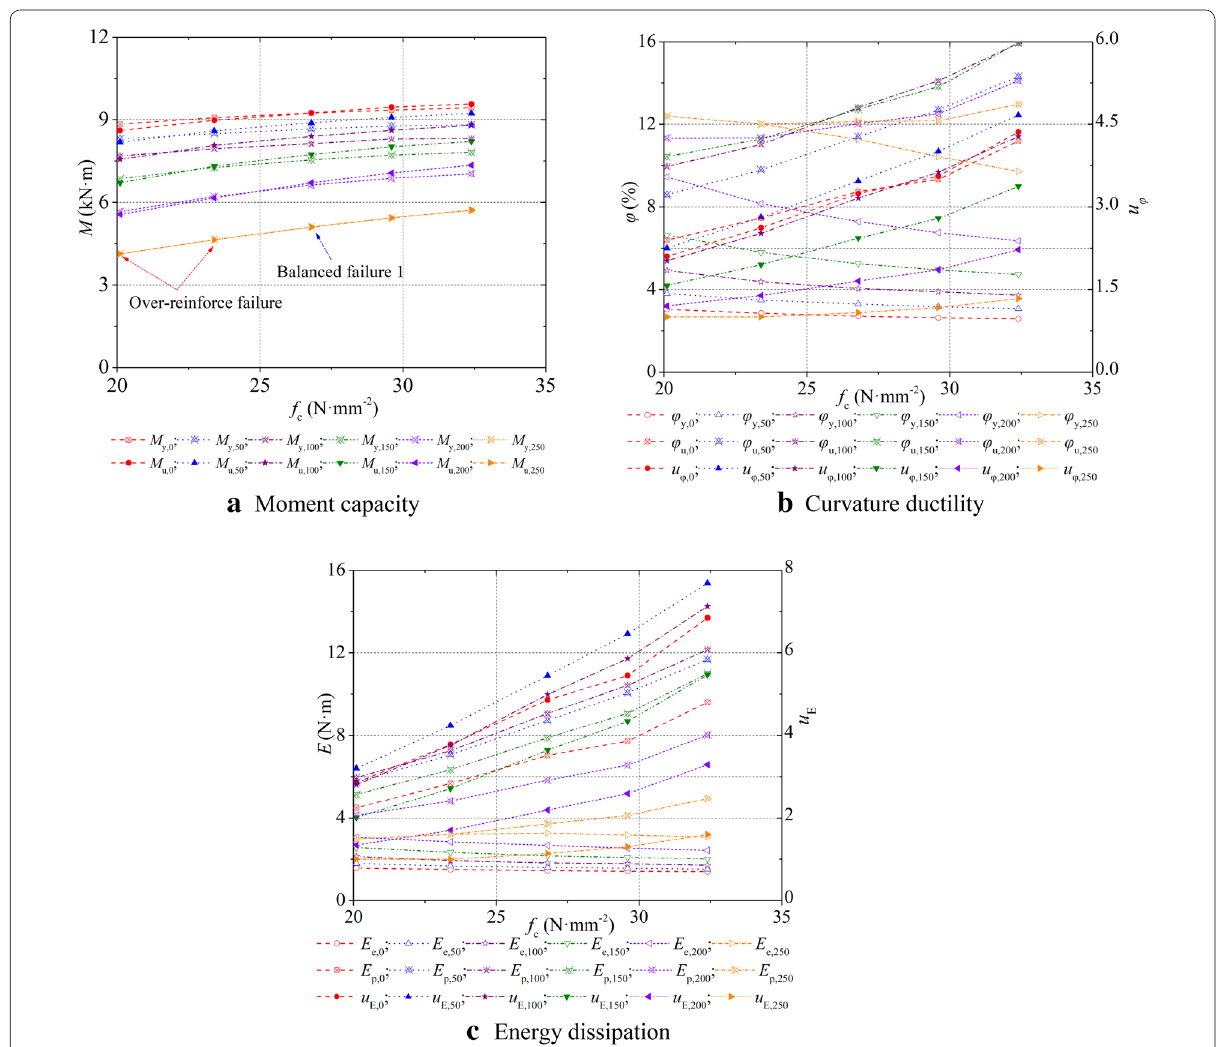
Fig. 17 Influence of concrete strength on moment capacity, curvature ductility and energy